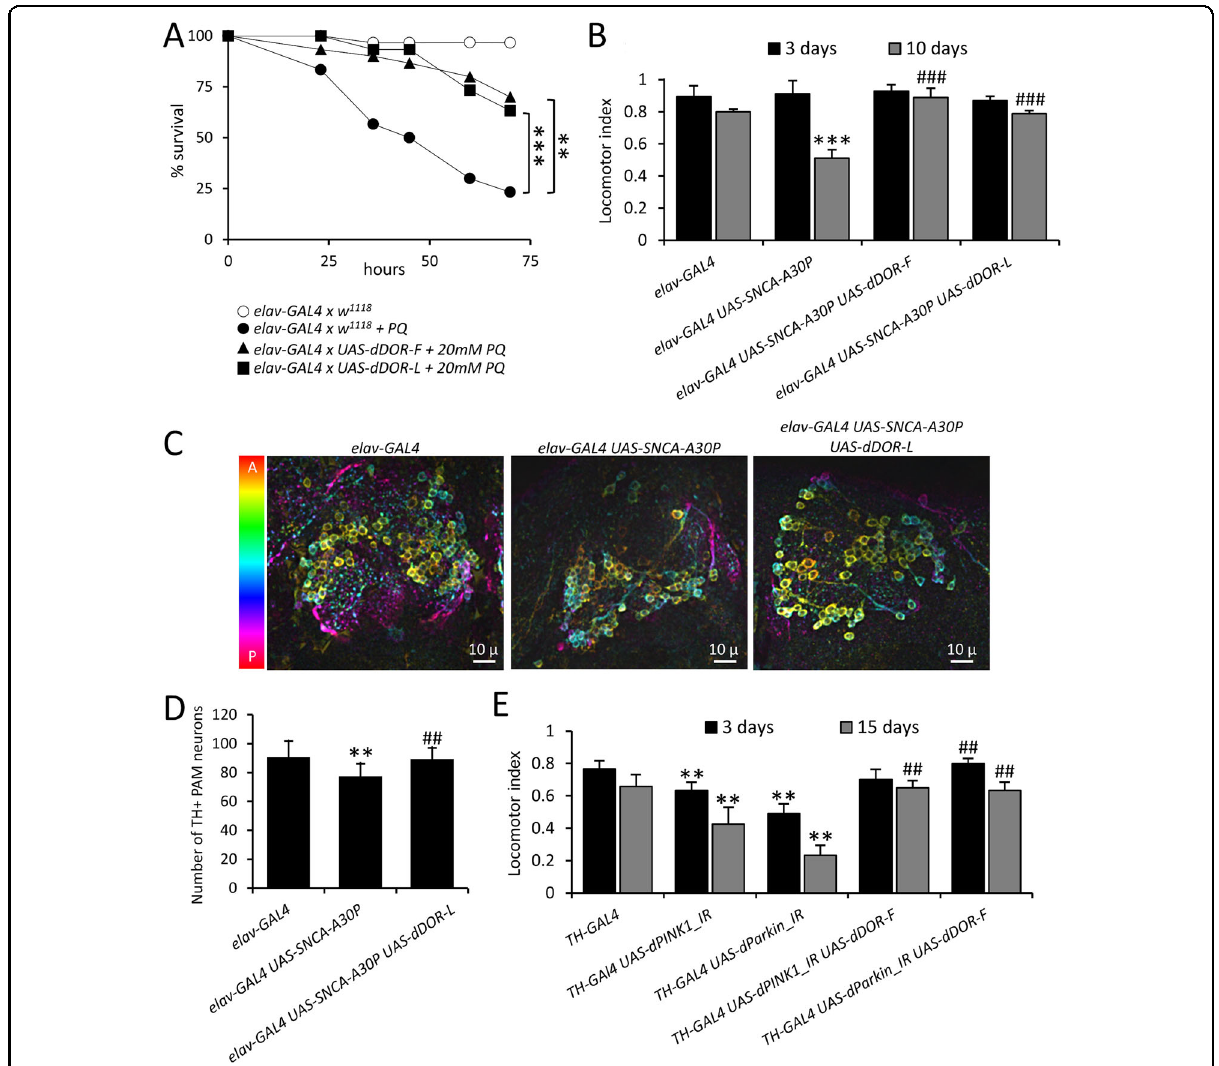
Fig. 4 Targeted neuronal overexpression of dDOR is neuroprotective in Drosophila models of Parkinson ’ s disease. A Survival curves on a 70- h period, showing the percent of survival of female fl ies fed with 2% sucrose (white disks) or poisoned with 20 mM Paraquat (PQ) diluted in 2% sucrose (black boxes, disks and triangles). UAS- dDOR transgenes ( dDOR-F but not dDOR-L contains EcR binding motif) were overexpressed using a pan-neuronal GAL4 driver ( elav-GAL4 ) and compared to the survival rate of elav-GAL4 fl ies crossed to w 1118 controls. Survival assay was performed on three groups of ten fl ies in each condition. Log-rank test results: ** P < 0.01, *** P < 0.0001. B Locomotor index determined by negative geotaxis tests performed on 3- and 10-day old adult male fl ies grown at 29 °C. Genotypes analyzed: hemizygous elav-GAL4 control fl ies (progeny of elav-GAL4 females and w 1118 males), fl ies overexpressing dDOR isoforms in neurons ( elav-GAL4 UAS-dDOR-F and L ), fl ies overexpressing human α -synuclein gene p.Ala30Pro in neurons ( elav-GAL4 UAS-SNCA-A30P ), fl ies overexpressing both dDOR isoforms and human α -synuclein gene p.Ala30Pro in neurons ( elav-GAL4 UAS-SNCA-A30P UAS-dDOR-F and L ). Mean of 9 races involving 30 fl ies in total (±SD). Mann – Whitney U test results: elav-GAL4 UAS-SNCA- A30P versus elav-GAL4 control *** P < 0.001; elav-GAL4 elav-GAL4 UAS-SNCA-A30P versus elav-GAL4 UAS-SNCA-A30P UAS-dDOR-F or UAS-dDOR-L ###P < 0.001 . C Z-projections of confocal image stacks showing DA neurons of the protocerebral anterior medial cluster (PAM) after TH immunolabelling of whole mounted brains from 15 days old adult male fl ies. Genotypes analyzed: hemizygous elav-GAL4 control males (progeny of elav-GAL4 females and w 1118 males), fl ies overexpressing human α -synuclein gene p.Ala30Pro in neurons ( elav-GAL4 UAS-SNCA-A30P ), fl ies overexpressing dDOR-L and human α -synuclein gene p.Ala30Pro in neurons ( elav-GAL4 UAS-SNCA-A30P UAS-dDOR-L ). The color code represents the Z-depth of the stack on the anterior (A) – posterior (P) brain axis. D Quanti fi cation of TH-positive neurons in PAM clusters imaged in brains of 15 days old adult male fl ies. Number of clusters analyzed in each genotype: 15 for elav-GAL4 , 16 for elav-GAL4 UAS-SNCA-A30 , 15 for elav-GAL4 UAS-SNCA-A30P UAS-dDOR-L . Mann – Whitney U test results: elav-GAL4 UAS-SNCA-A30P versus elav-GAL4 control ** P < 0.01; elav-GAL4 elav-GAL4 UAS-SNCA-A30P versus elav-GAL4 UAS-SNCA-A30P UAS-dDOR-L ##P < 0.01 . E Locomotor index determined by negative geotaxis tests performed on 3- and 15-day old adult male fl ies grown at 29 °C. Genotypes analyzed: heterozygous TH-GAL4 control fl ies (progeny of TH-GAL4 females and w 1118 males), fl ies overexpressing RNAi against Drosophila dPINK1 or dParkin in DA neurons ( elav-GAL4 UAS-dPINK1_IR or UAS-dParkin_IR ), and fl ies overexpressing both dDOR-F and RNAi against dPINK1 or dParkin in DA neurons ( elav-GAL4 UAS-dPINK1_IR or UAS-dParkin_IR UAS-dDOR-F ). All genetic conditions include a UAS-Dicer2 transgene. Mean of 9 races involving 30 fl ies in total (±SD). Mann – Whitney U test results: TH-GAL4 UAS-dPINK1_IR or UAS-dParkin_IR versus TH-GAL4 control ** P < 0.01;